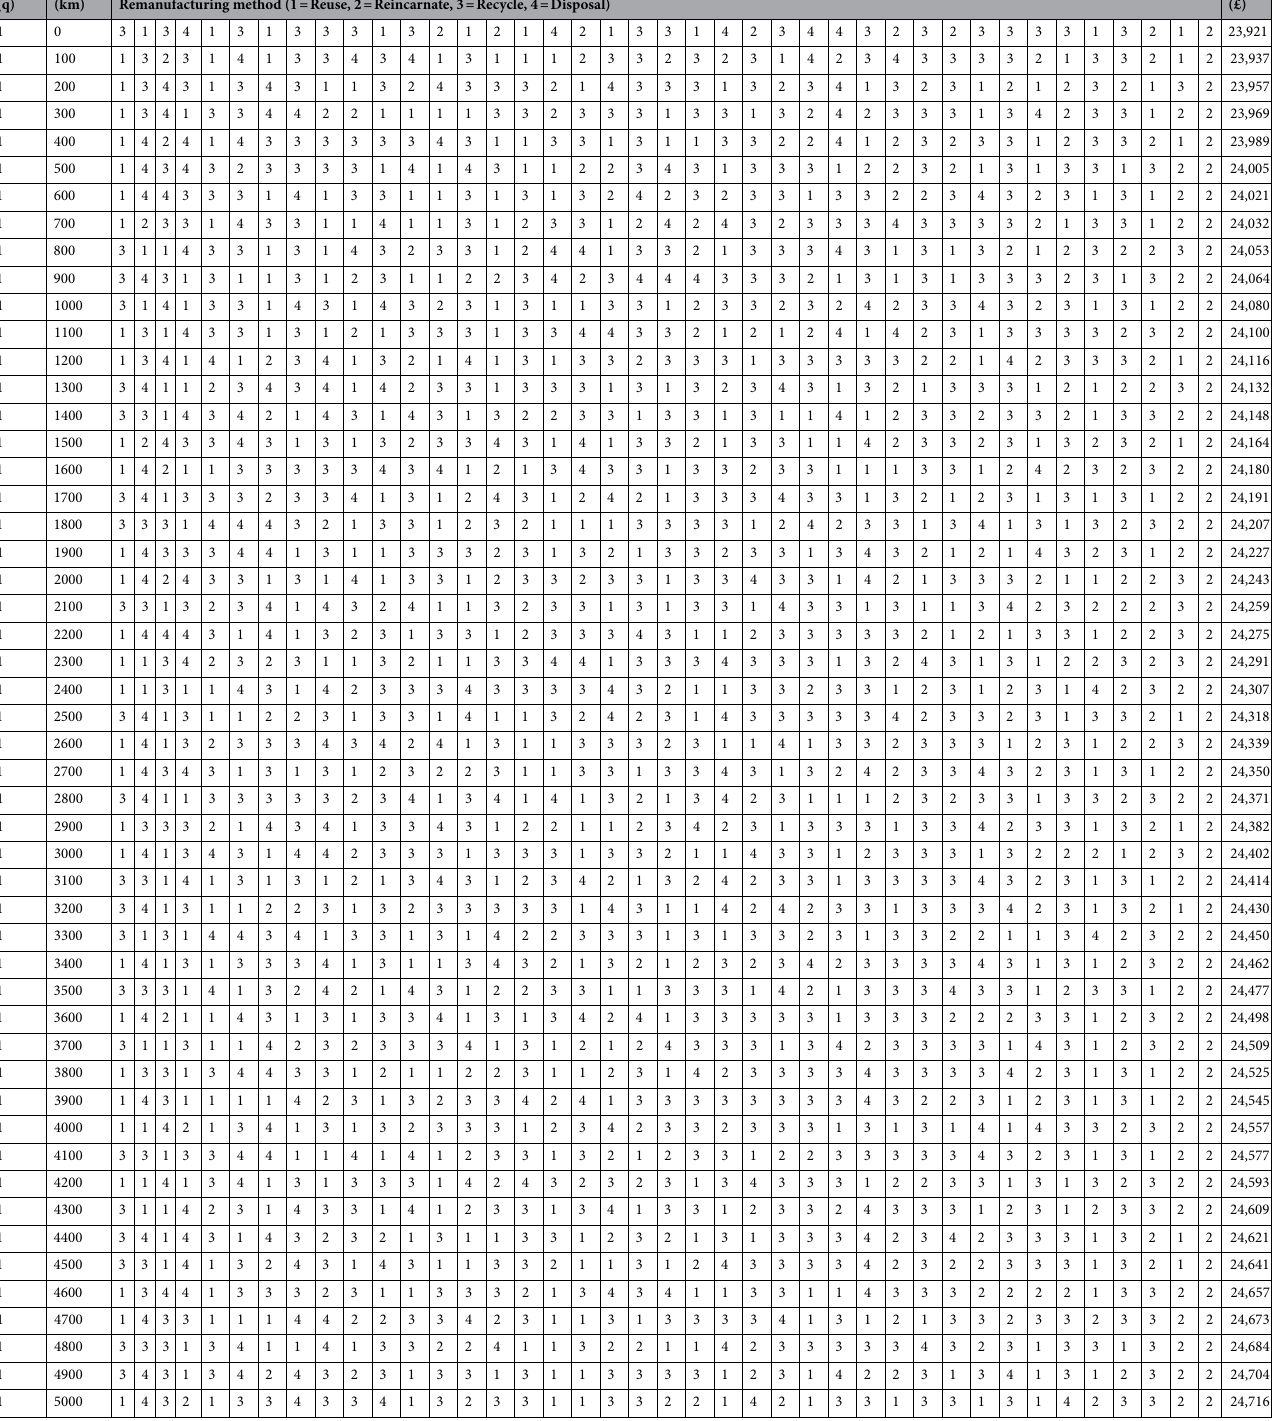
Table 3. BA-generated routing and costs related to the sequences in Table